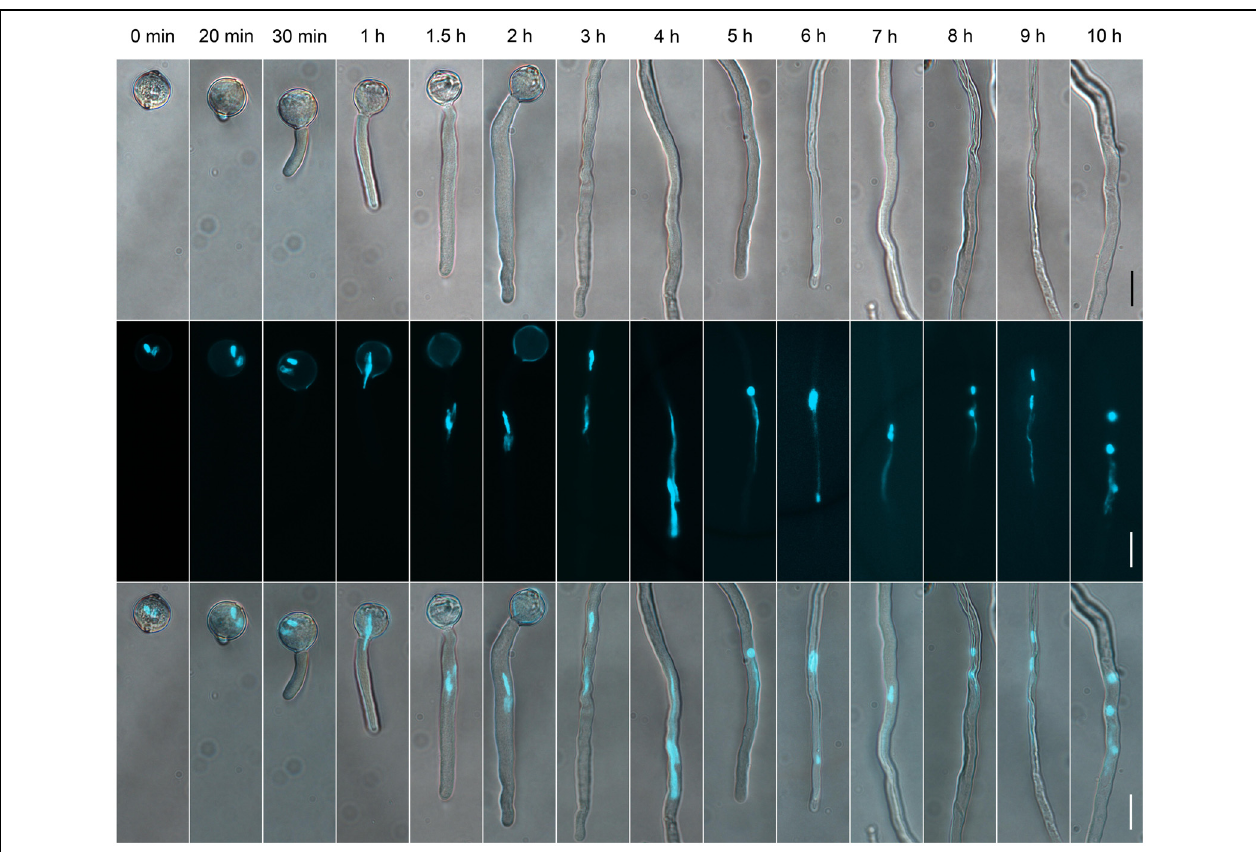
FIGURE 1 | The dynamics of generative cells (GCs) and sperm cells (SCs) during pollen germination and tube growth. Pollen cultured at different times observed by differential interference contrast (DIC) microscopy (upper panel), or after 4 (cid:4) ,6-diamino-2-phenylindole (DAPI) staining (middle panel) . Merged images in the bottom panel. Scale bar: 20 μ m.